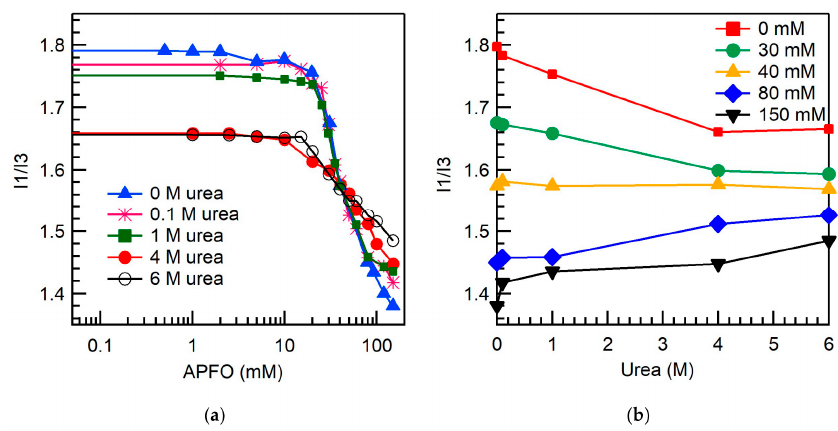
Figure 3. ( a ) Pyrene fluorescence intensity I1 / I3 ratio of APFO aqueous solutions plotted versus surfactant concentration in the absence and in the presence of urea (at various concentrations shown inside the graph) (22 ◦ C); ( b ) variation with urea concentration of the pyrene fluorescence intensity I1 / I3 ratio of APFO at various concentrations (shown inside the graph) in aqueous solution. The lines connecting the data points are meant as guides to the eye.